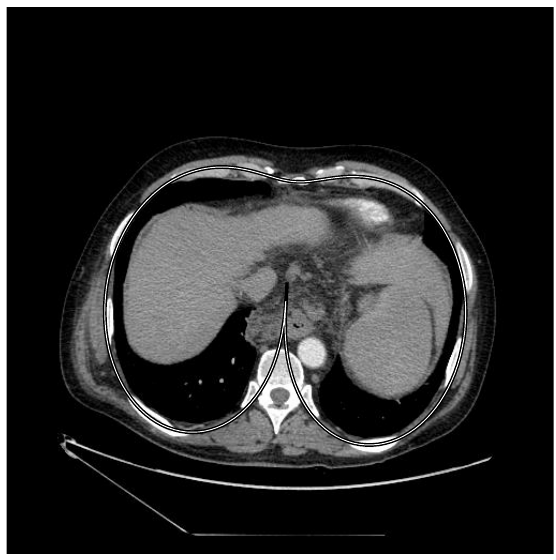
Fig. 4. The ribs-bounded